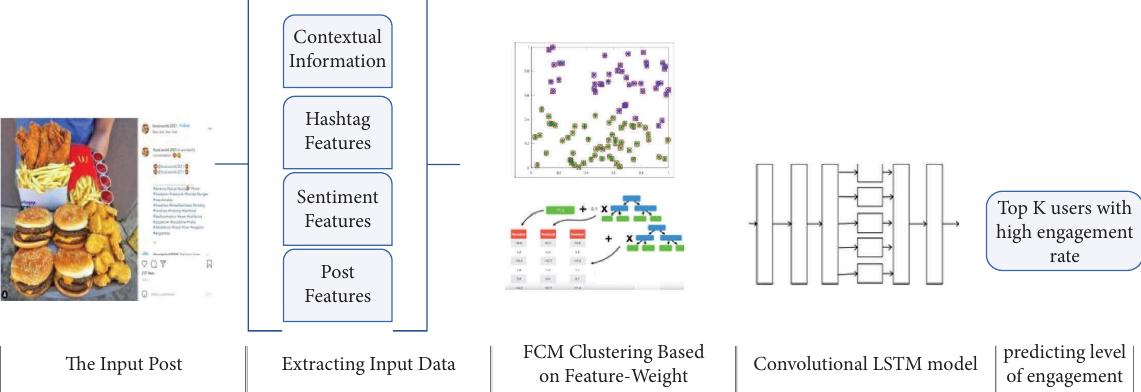
Figure 3: Structure of the proposed approach.